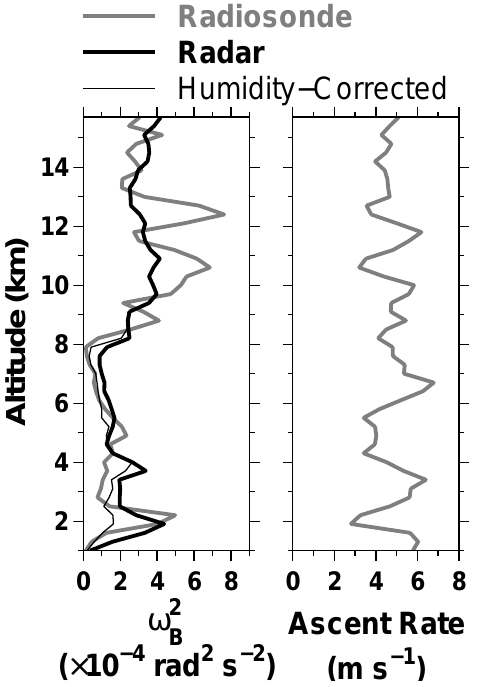
Fig. 5. An example of large discrepancies between the radiosonde- derived (thick grey line) and radar-derived (thick black line) values of ω 2 (left panel) corresponding to 08:18 UT on 1 November 1999. B The radiosonde’s ascent rate is shown in the right